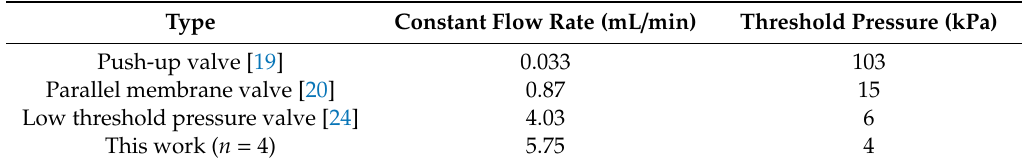
Table 3. Comparison of the di ff erent types of passive flow control valves.